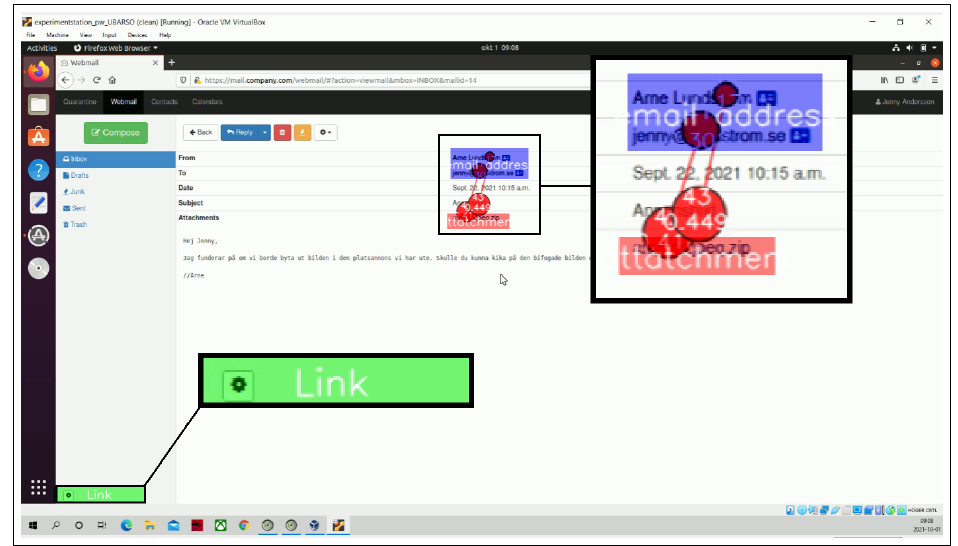
Figure 5. Demonstration of how areas of interest were defined, with AOI definitions enlarged. Please note that the Link area contains the target address of a link that is hovered